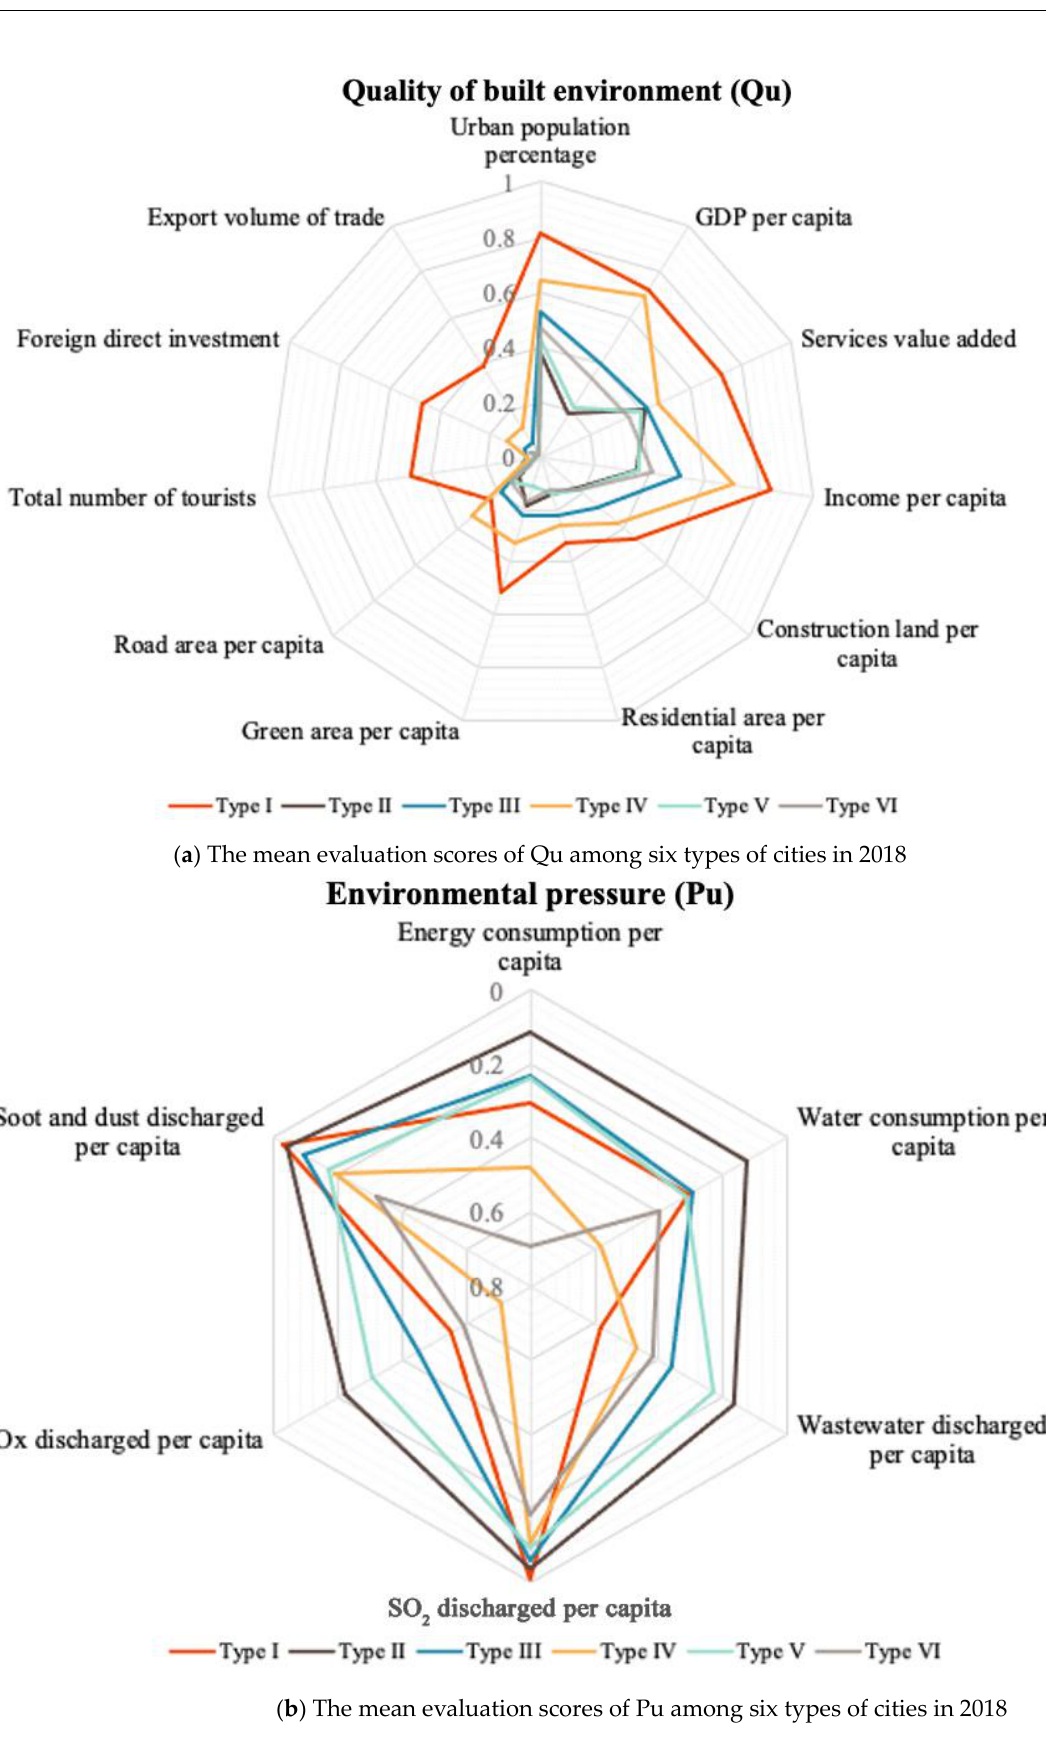
Figure 10. Comparison of the mean evaluation scores among six types of cities in 2018.